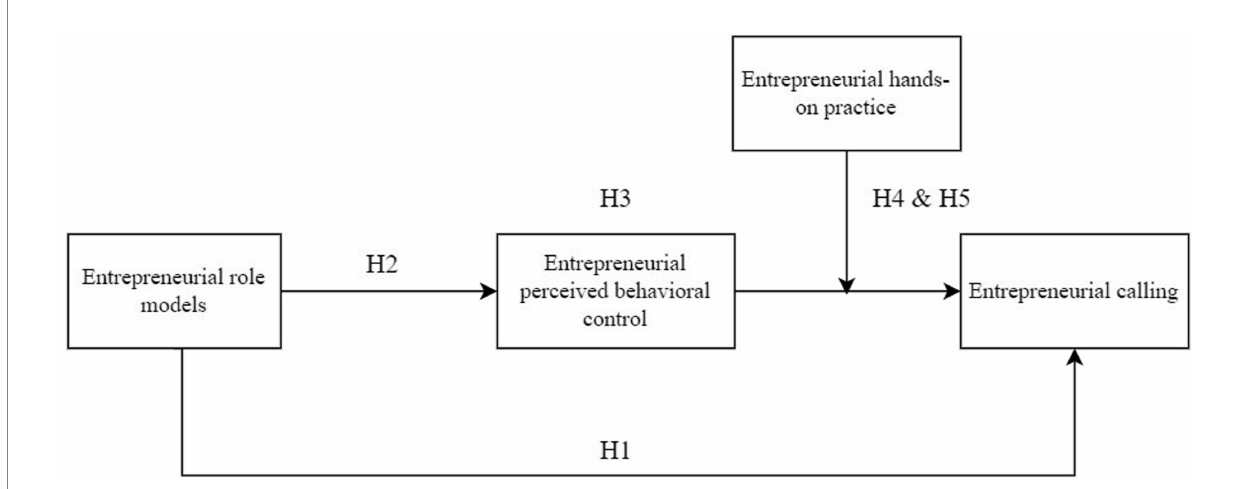
FIGURE 1 The mediated moderation